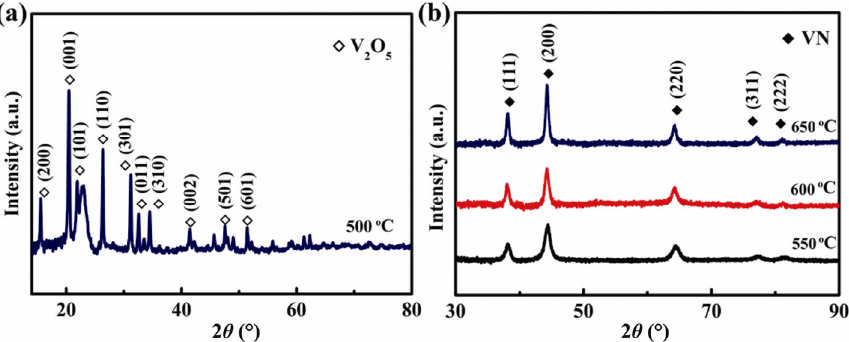
Fig. 4 XRD patterns of (a) V 2 O 5 nanofibers and (b) VN nanofibers nitrided at 550, 600, and 650 ℃ in